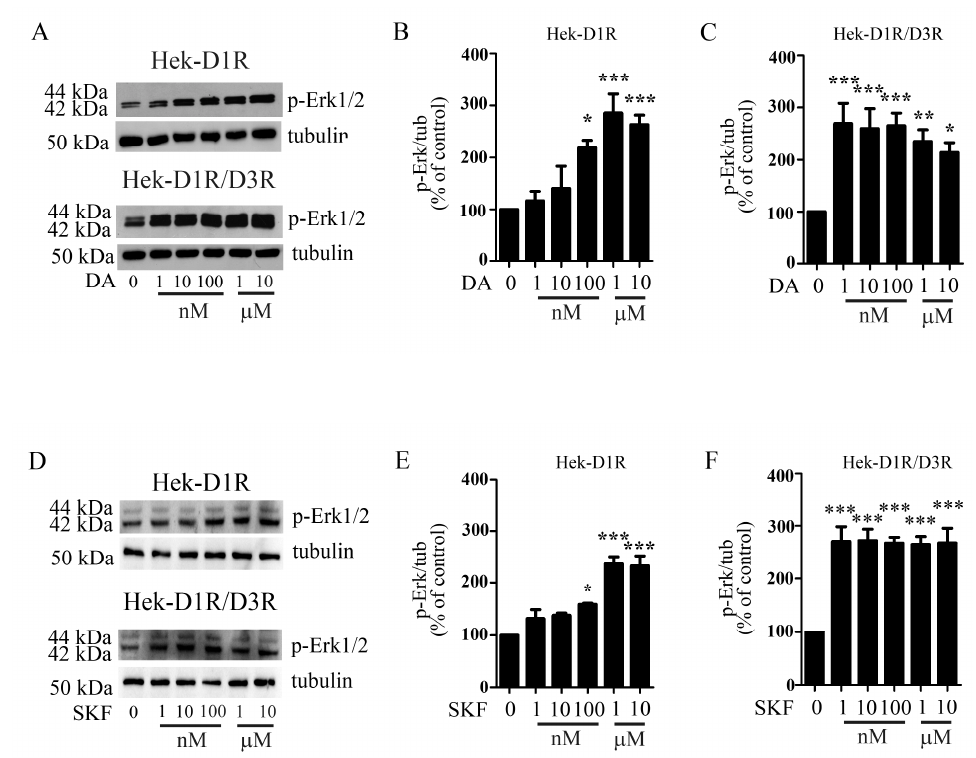
Figure 4. In Hek-D1R/D3R cells, the Interaction of D1R with D3R increases the ability of DA or D1R agonists in activating the Erk1/2 pathway. ( A ) Hek-D1R and Hek-D1R/D3R cells were treated with different doses of DA (1–10 µ M) for 5 min and analyzed for p-Erk1/2; a representative WB is shown; ( B , C ) densitometric analysis of blots (n = 4) with specific p-Erk1/2 levels normalized to the corresponding tubulin levels. Bars represent the mean ± S.E.M. * p < 0.05, *** p < 0.001 vs. untreated cells. ( D ) Hek-D1R and Hek-D1R/D3R cells were treated with different doses of SKF (1–10 µ M) for 5 min and analyzed for p-Erk1/2; a representative WB is shown; ( E , F ) densitometric analysis of blots with specific p-Erk1/2 levels normalized to the corresponding tubulin levels. Bars represent the mean ± S.E.M. * p < 0.05, ** p < 0.01, *** p < 0.001 vs. untreated cells (n = 4). Data were statistically analyzed using one-way ANOVA followed by post hoc comparison with the Bonferroni